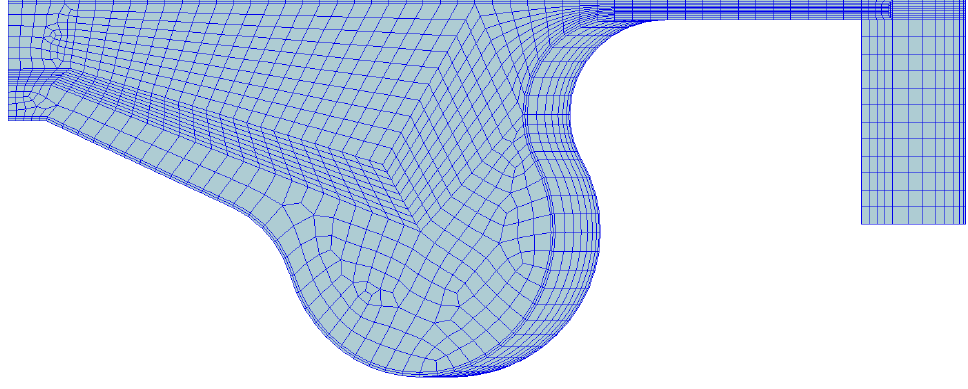
Figure 1. Three dimensional CFD simulation model of the cylinder. Table 1. Key parameters of the diesel engine.